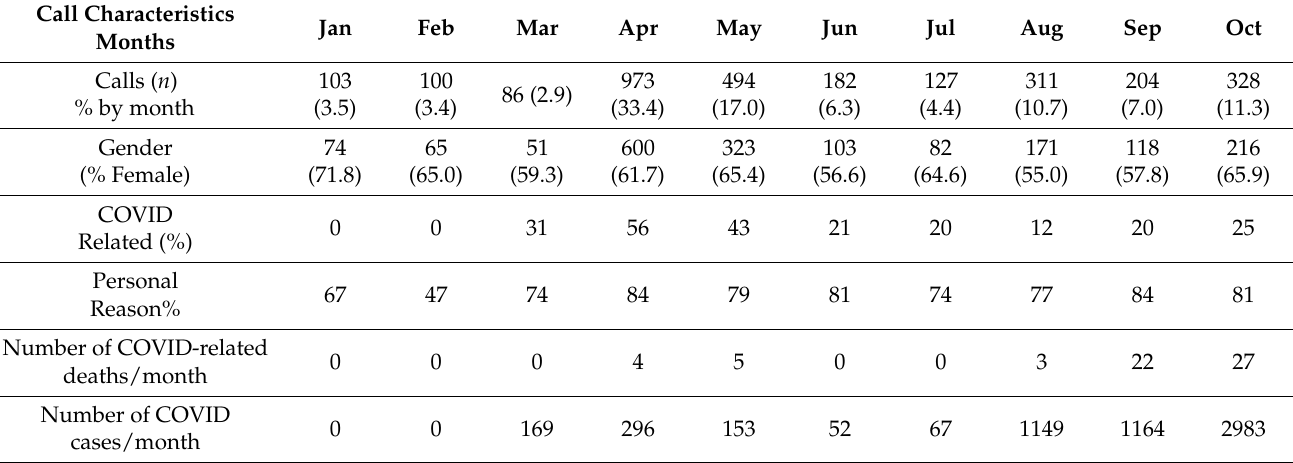
Table 1. Trends in number of calls by